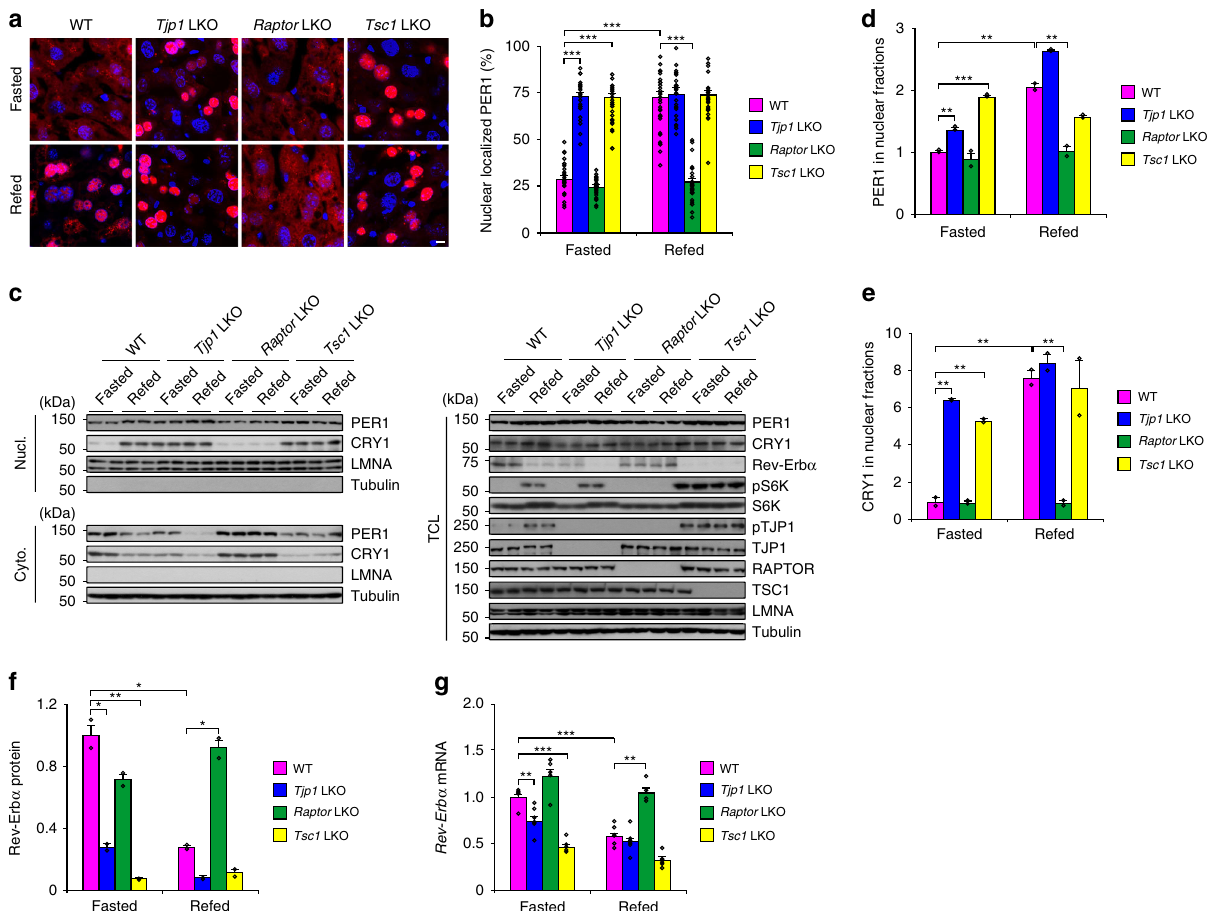
Fig. 5 TJP1 and mTOR mediate feeding-induced nuclear translocation of PER1. a and b Cellular localization of mCherry-PER1 a and the statistical analysis of nuclear-localized mCherry-PER1 b in the liver from mice fasted from ZT12 to ZT4 or refed for another 2 h from ZT4 to ZT6. c Immunoblots showing amounts of PER1 in nuclear fractions of liver extracts from mice fasted from ZT12 to ZT4 or refed for another 2 h from ZT4 to ZT6. d – f Statistical analysis of PER1 d and CRY1 e in Nucl. and Rev-Erb α in TCL f from immunoblots as shown in c . g qPCR results showing the relative mRNA level of Rev-Erb α in liver extracts from mice fasted from ZT12 to ZT4 or refed for another 2 h from ZT4 to ZT6. Data are shown as mean ± s.e.m. Comparison of different groups was carried out using two-way ANOVA. *P < 0.05, **P < 0.01, ***P < 0.001, n = 5 – 7 mice. Source data are provided as a Source Data fi